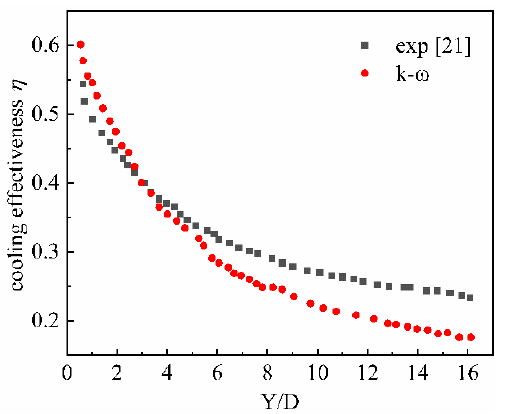
Figure 10. Validation of the computational method for overall cooling effectiveness.